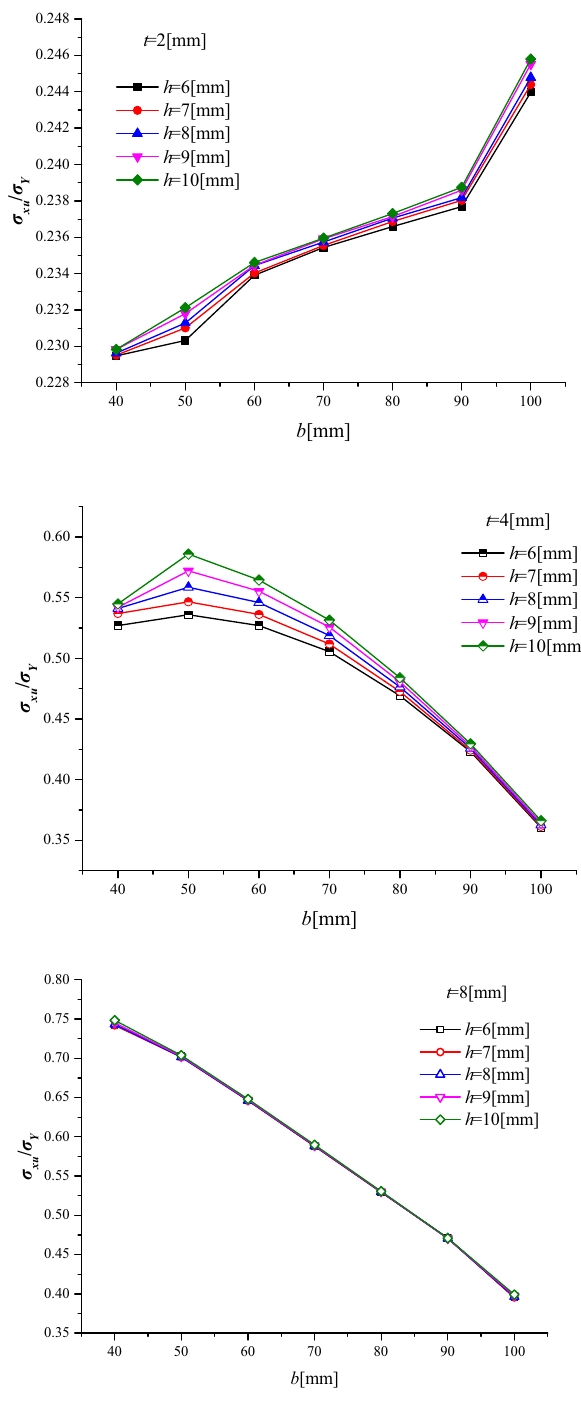
Figure 5: In fl uence of elliptical shape on ultimate